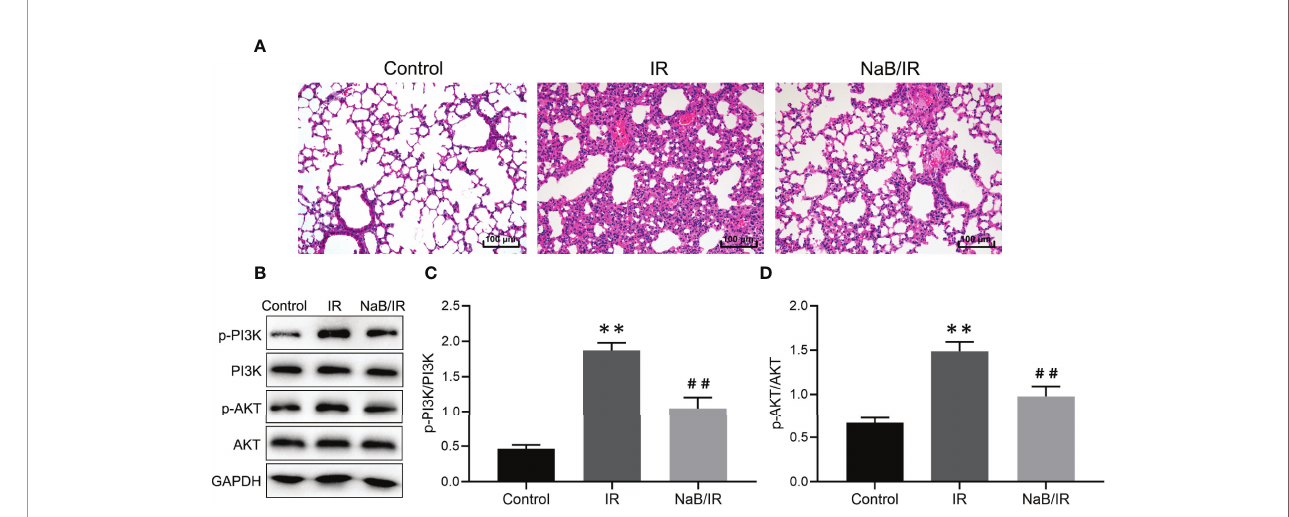
FIGURE 15 | Sodium butyrate treatment attenuates radiation-induced lung injury. (A) Hematoxylin and eosin staining of lung tissues 1 week after radiation administration. Scale bar 100 m m. (B) The protein levels of p-PI3K, PI3K, p-AKT and AKT in lung tissue were detected by Western blot. (C, D) Quantitative analysis of (B) . Results are representative of three independent experiments, and the differences between data were evaluated by one-way ANOVA, with p value less than 0.05 considered statistical signi fi cance. ** p < 0.001 vs. Control; ## p < 0.05 vs.